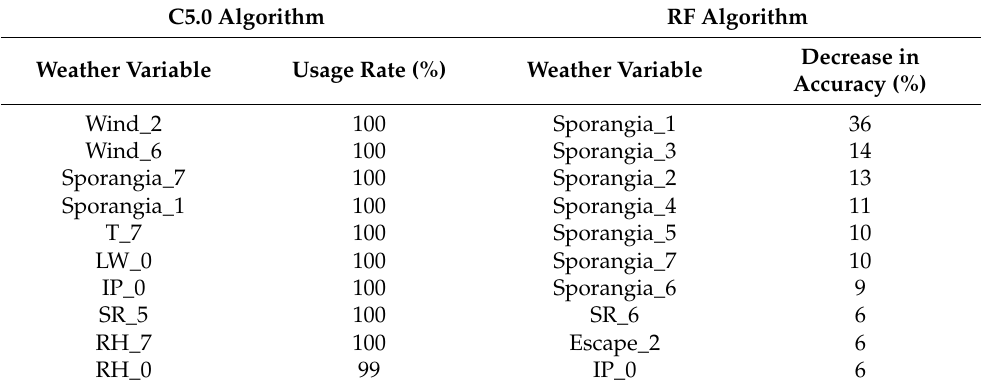
Table 5. Weather and sporangia variables in order of importance of selection according to ML